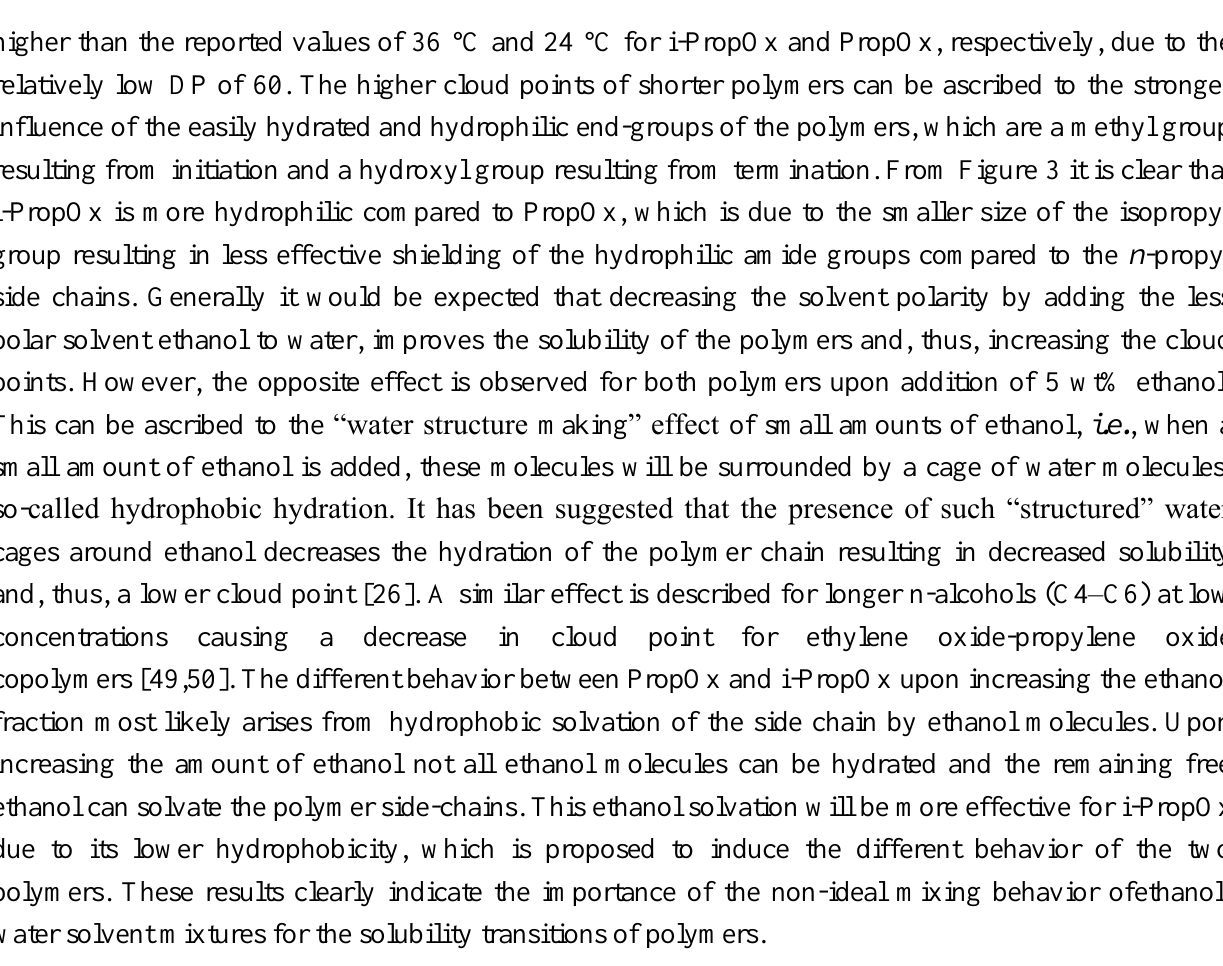
Figure 3. Cloud points as function of wt% ethanol for the LCST transitions of poly(2-propyl-2-oxazoline) (PropOx) and poly(2-isopropyl-2-oxazoline) (i-PropOx) at 5 mg/mL